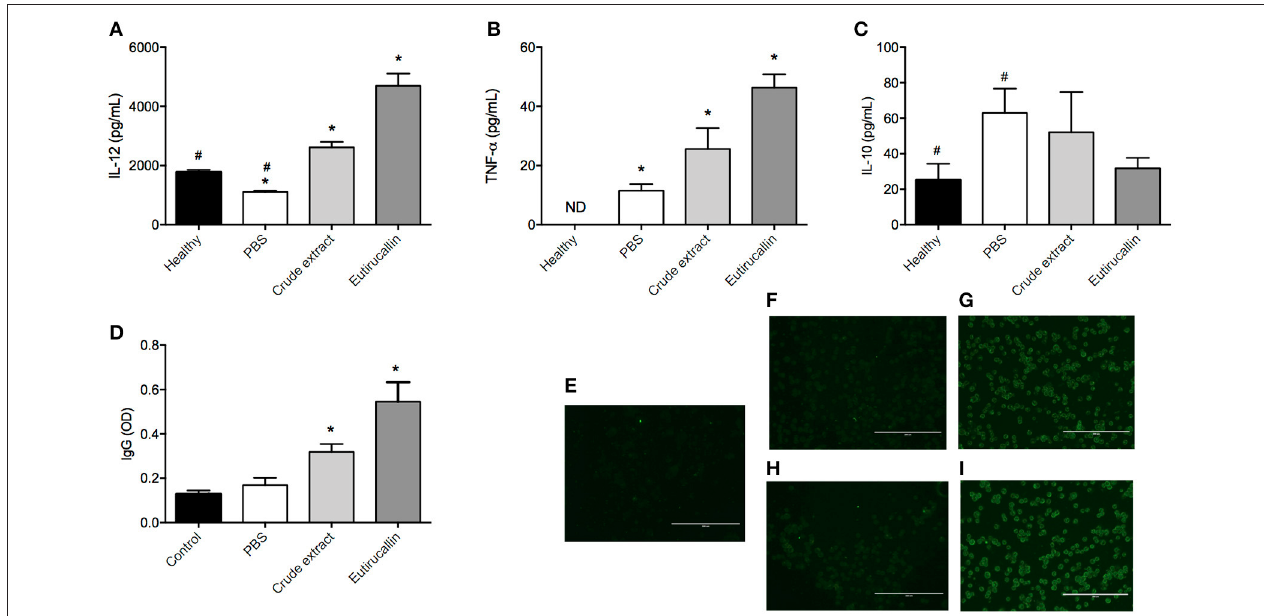
FIGURE 7 | Quantification of cytokines, total IgG and fluorescence of Ehrlich cells. Quantification of IL-12 (A) , TNF- α (B) , IL-10 (C) , and IgG (D) analyzed in the serum of healthy mice and EAC bearing mice treated daily intraperitoneally with PBS and 50 ug of Crude extract and Eutirucallin. * and # represents statistically difference ( P < 0.05) between indicated groups. For immunofluorescence, mice were immunized with crude extract or Eutirucallin to obtain their specific anti-serum. Immunofluorescence indicates the binding of Eutirucallin in the EAC membrane. A control with no immunized mice was used (E) . The anti-serum was incubated with fixed EAC without crude extract (F) and Eutirucallin (H) or with crude extract (G) and Eutirucallin (I) . Bars indicate